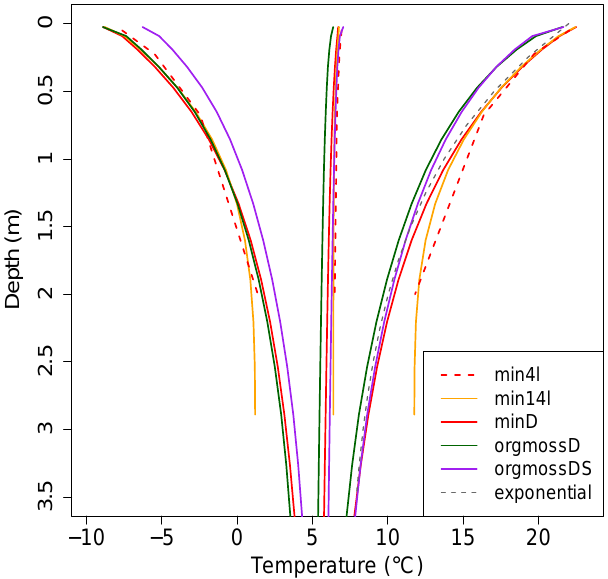
Figure 10. The annual maximum, minimum and mean of simu- lated soil temperatures (right-hand, left-hand and centre lines re- spectively), averaged over the period 1979–1989, for the land area north of 50 ◦ latitude. Comparing the simulations with different soil depth is of particular interest